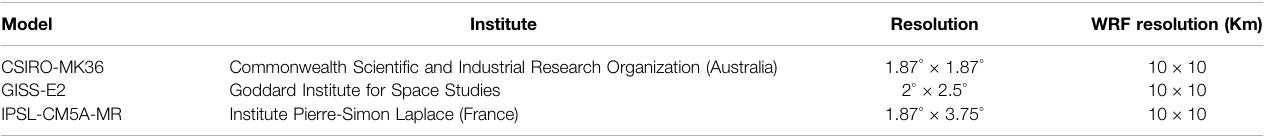
TABLE 1 | Models used in this